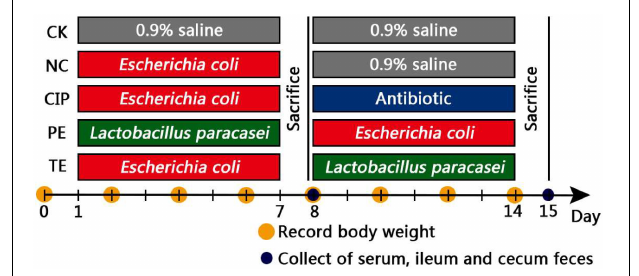
FIGURE 1 | Treatment scheme of L. paracasei intervention.